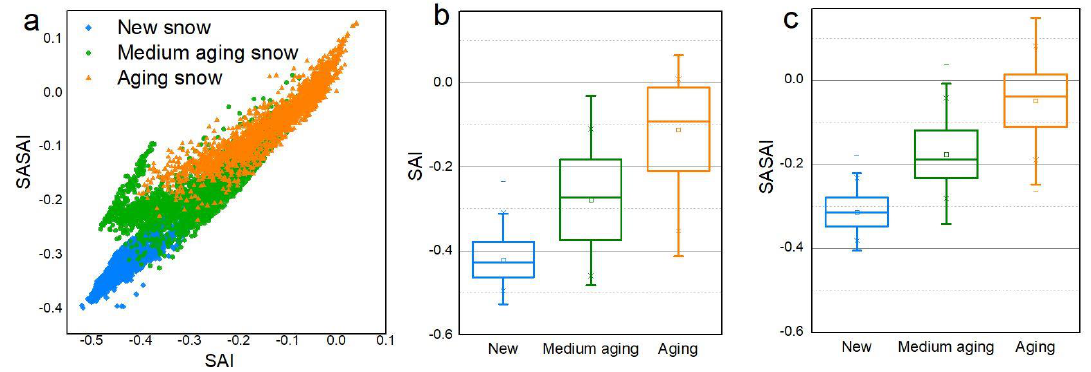
Figure 11. The SAI / SASAI scatterplot ( a ), and boxplots of SAI values ( b ) and SASAI values ( c ) for three Figure 11. SAI versus SASAI plot for three types of validation samples. types of verification samples. Figure 11. SAI versus SASAI plot for three types of validation samples.